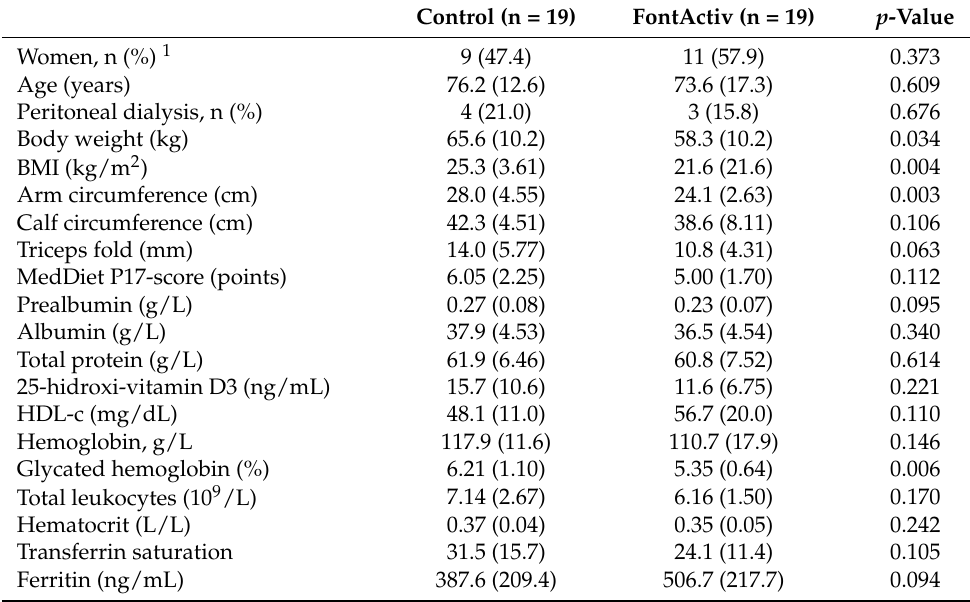
Table 1. Baseline characteristics according to intervention